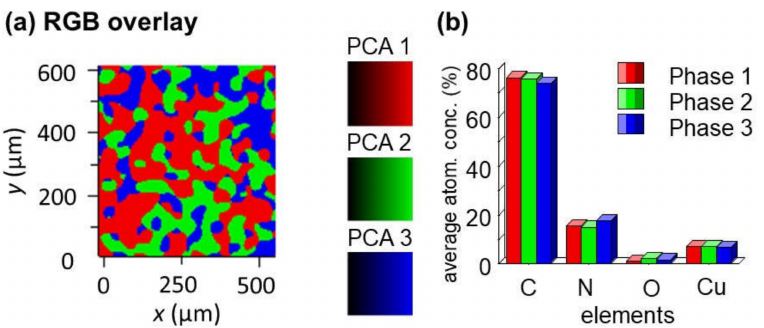
Figure 4. XPS imaging for 2PhI-treated Cu to obtain ( a ) the PCA-RGB image, and ( b ) the correspond- ing elemental average atomic concentration in each phase.